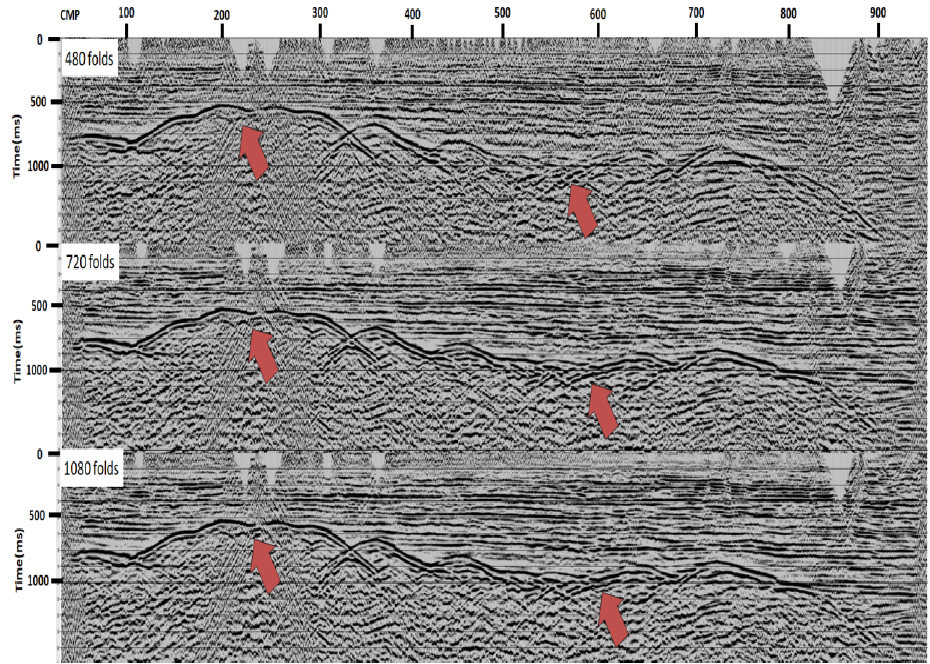
Figure 10. Comparison of the stacking sections of the data acquired using different folds in a sedi ‐ mentary rock thermal storage